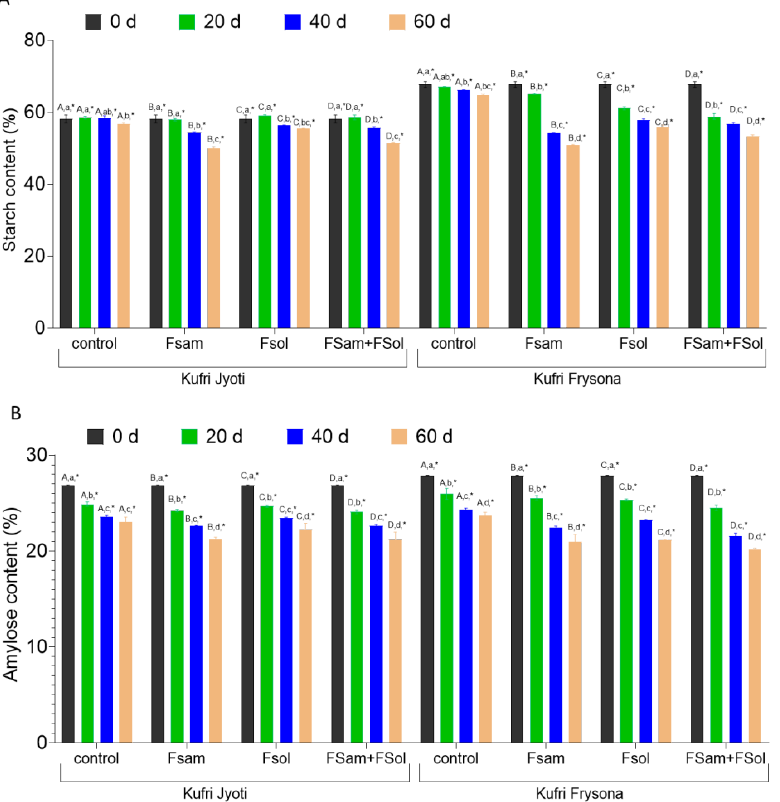
Figure 5. The effect of dry rot infection on ( A ) starch content ( B ) amylose content in cultivars Kufri Jyoti and Kufri Frysona; control, no pathogen infection; FSam, Fusarium sambucinum ; FSol, Fusarium solani ; FSam + FSol, Fusarium sambucinum + Fusarium solani . Capital letter = significance of inoculum (within one date/cultivar combo); Lower case letter = significance of date (within one inoculum/ cultivar combo); * = significance between cultivars (within one inoculum/date combo).